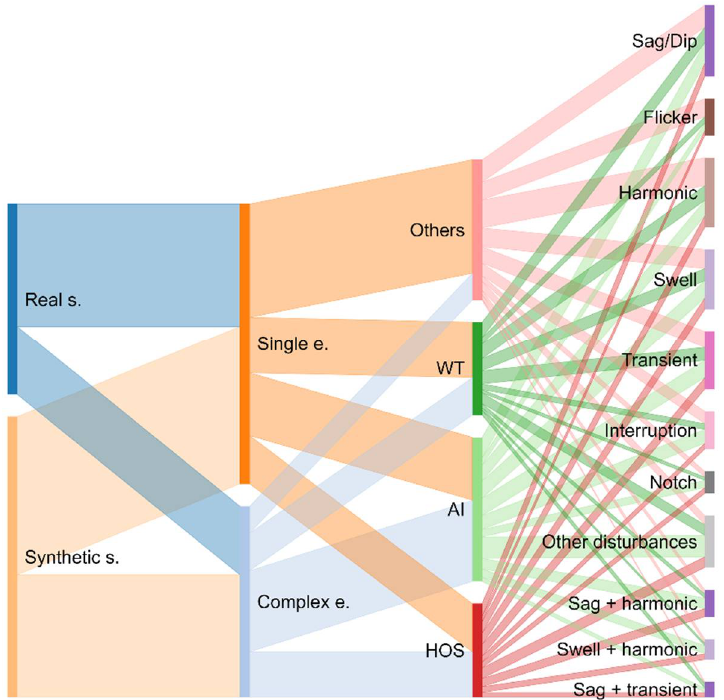
Figure 5. Parallel set that relates the signal source with the complexity of events, the method used, and the PQ disturbances, grouping the less common events. and the PQ disturbances, grouping the less common